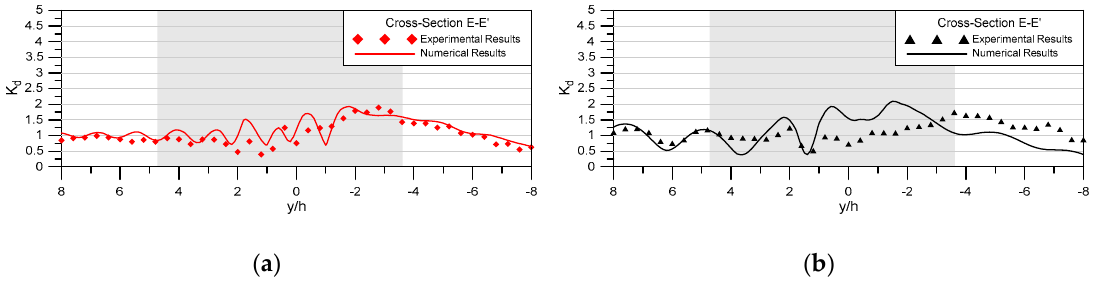
Figure 9. Comparison of the experimental and numerical wave-height ratios K d at cross-section E–E ′ for wave conditions of ( a ) σ 2 h / g = 2.012 and ( b ) σ 2 h / g = 0.894 at oblique incidence ( α = 120 ◦ ) . The shaded area indicates where the plate starts and ends for the given cross-section.